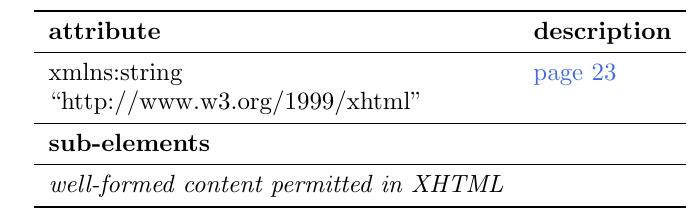
Table 2.2: Attributes and nested elements for Notes. o denotes optional elements and